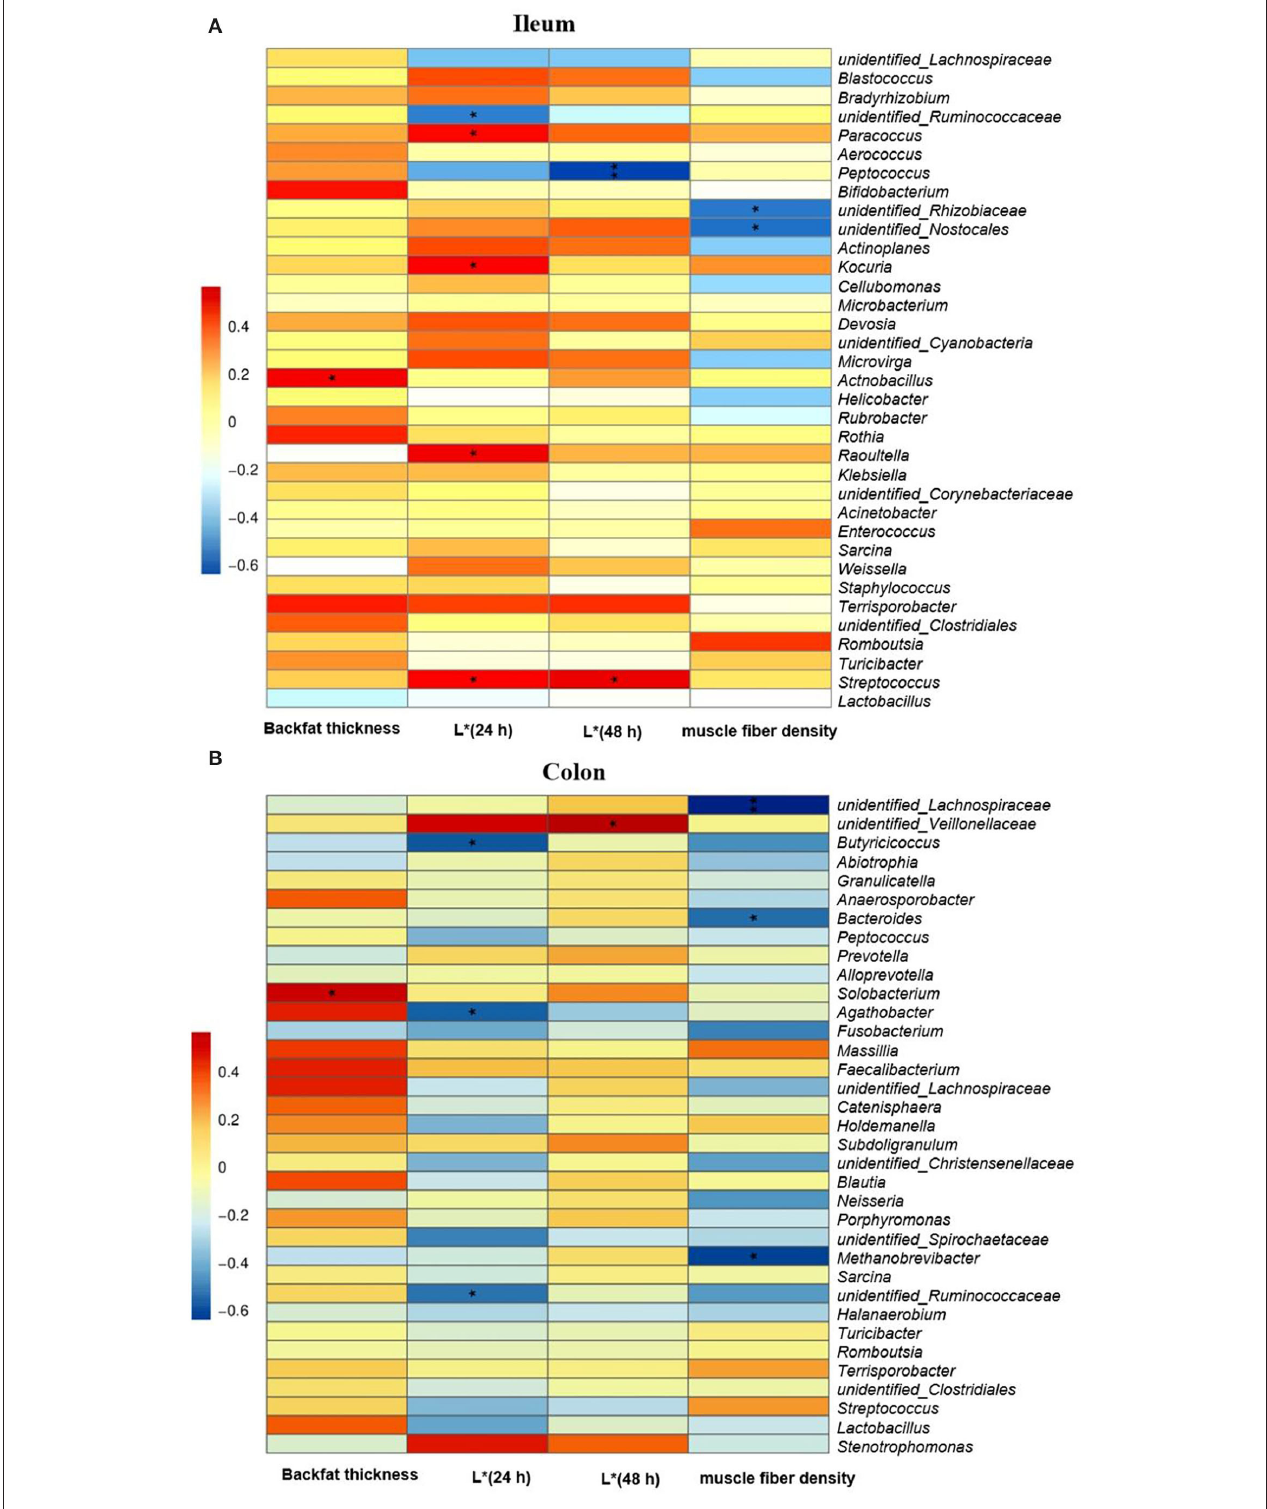
FIGURE 7 | The Spearman correlation analysis of gut microbial composition at genus level with carcass trait and meat quality of finishing pigs. Spearman correlation coefficients of backfat thickness at first rib, meat color L* at 24 and 48h and muscle fiber density with ileal (A) and colonic (B) microbiota, are represented by color ranging from red (positive correlation) to blue (negative correlation). * and **indicates statistically significant difference ( P < 0.05) and ( P < 0.01), respectively.